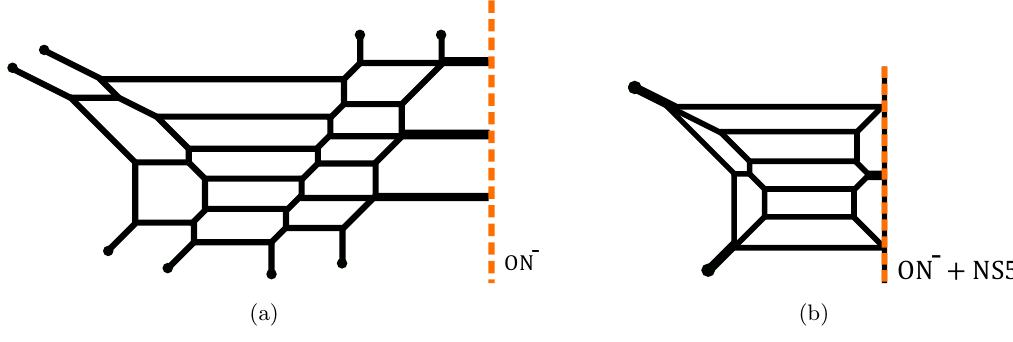
Figure 9 . (a) A 5-brane diagram for the SU(6) 1 the SU(6) 1 gauge theory with N TAS = 3 2 (cid:12)gure